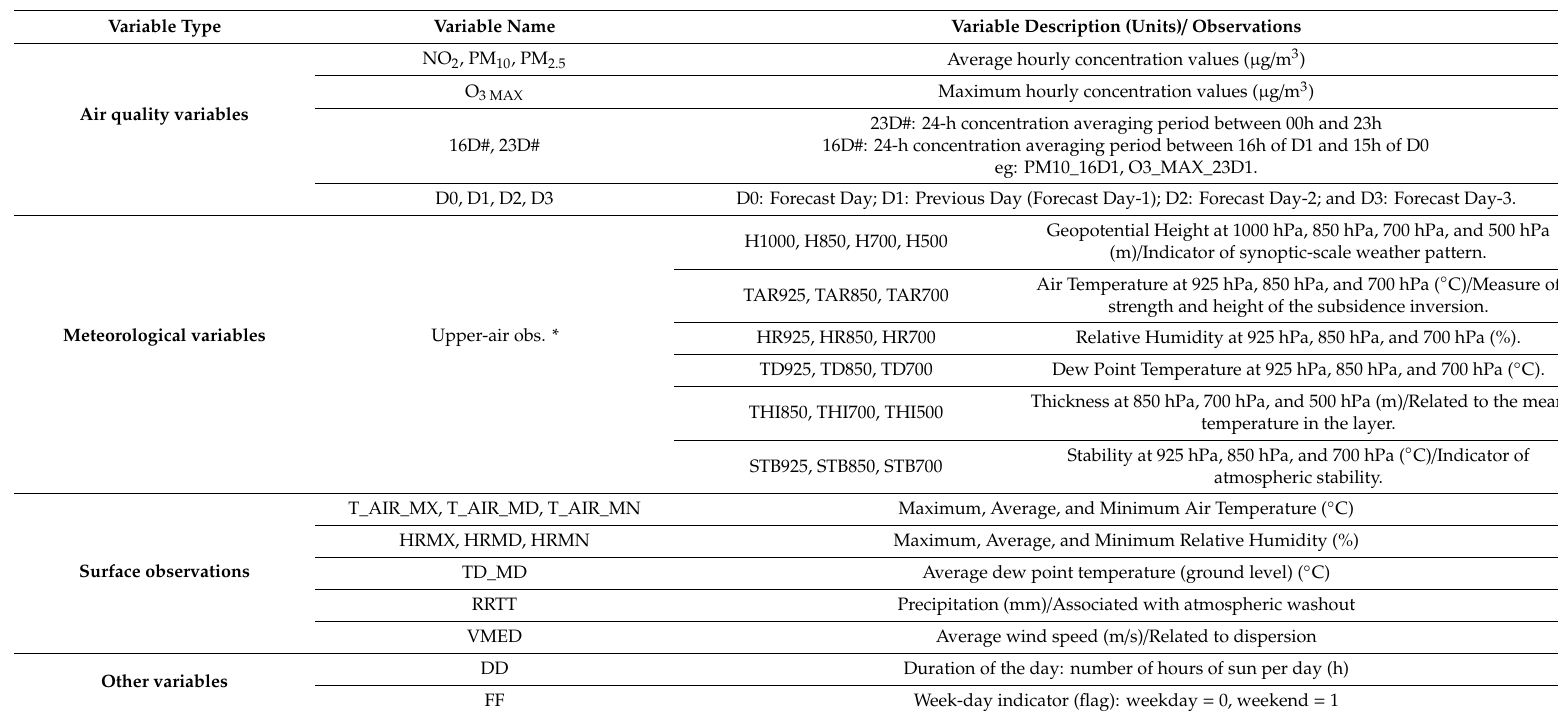
Table 1. Variables considered as predictors in the multiple linear regression (MLR) and classification and regression tree (CART) models in all of the air quality forecast